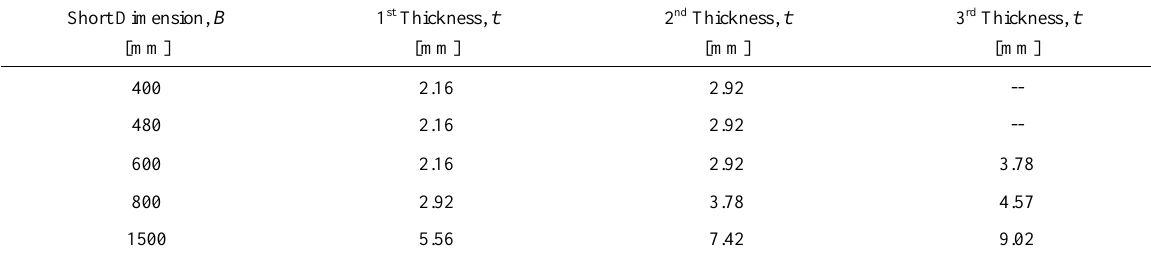
Table 1: Finite element model specimens for each aspect ratio